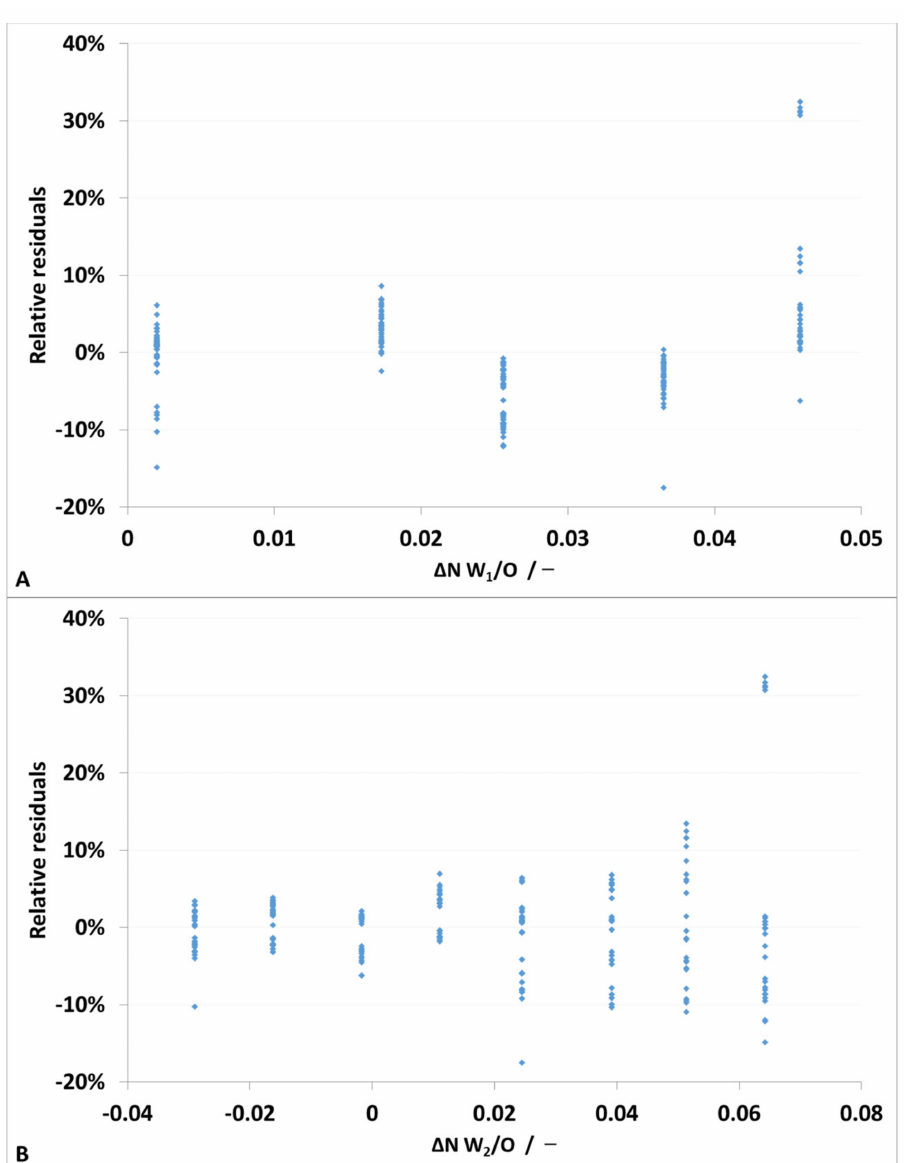
Figure 7. Residues as a function of refractive index difference between the inner water and oil phase ( A ) and the outer water and oil phase ( B